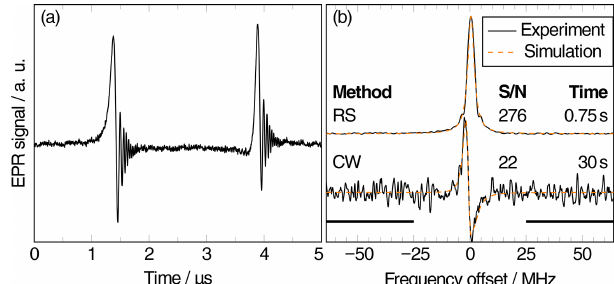
Figure 2. (a) The background-corrected AM RS-EPRoC time trace recorded at a scan rate of 80THzs − 1 (corresponding to 2.9kTs − 1 ; (cid:49)f m = 64MHz, f m = 200kHz, I bias = 7mA, B 1 = 46µT). (b) Experimental data (black) and simulations (orange) of the CW ( I bias = 5mA, B 1 = 27µT) and the deconvolved RS spec-